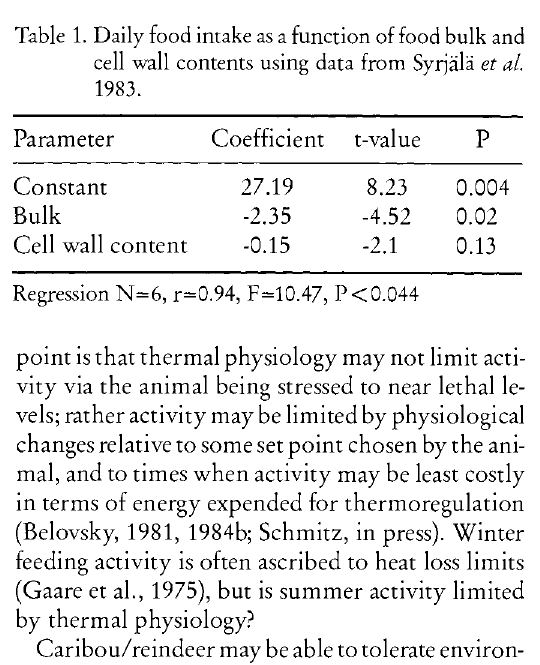
Table 2. Development of the digestive capacity constraint for a 70 kg female caribou/reindeer. L is lichen intake (g-dry/day) and NL is non-lichen intake (g-dry/day).